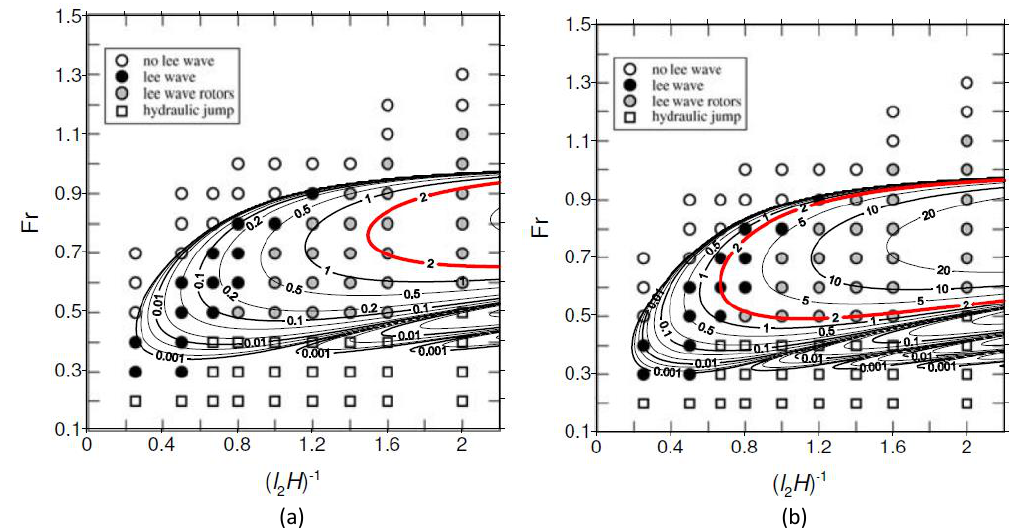
Figure 2. ( a ) and ( b ) should replace Figure 4a,b in [1].